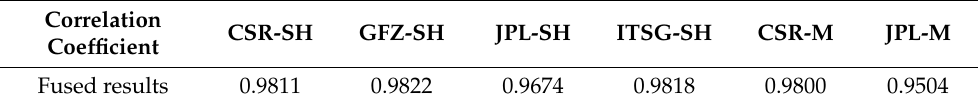
Figure 4. The time-series of TWSC derived from the six GRACE solutions and fused results. Table 2. The correlation coefficients between the fused results and TWSC results from the six GRACE solutions.